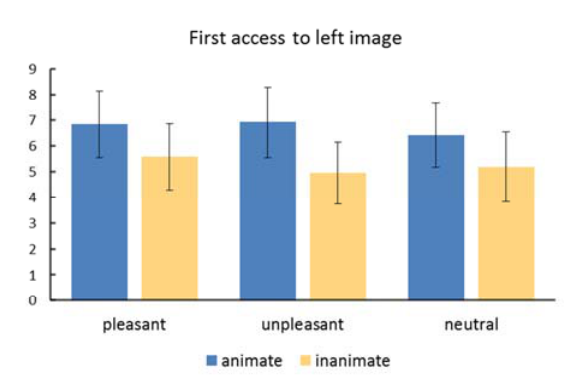
Figure 4 - Mean number of first accesses to animate vs. in- animate left images within the three categories of valence. Ver- tical bars indicate standard